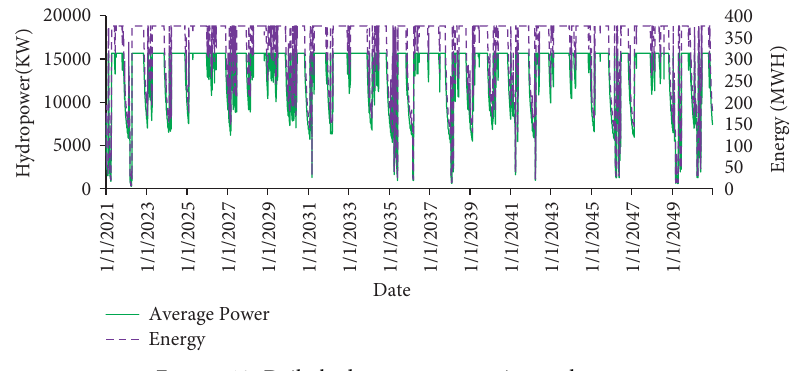
Figure 19: Daily hydropower generation and